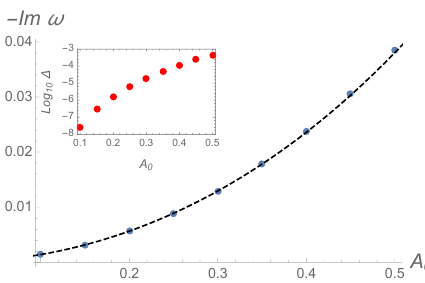
Figure 2 . Imaginary part of the smallest QNM for varying amplitude at q = 0. The dashed line shows our perturbative result. Since the di(cid:11)erence between the numerical and analytic results is not appreciable, in the inset we show their di(cid:11)erence (cid:1) as a function of the amplitude A 0 . We observe that the agreement worsens for larger